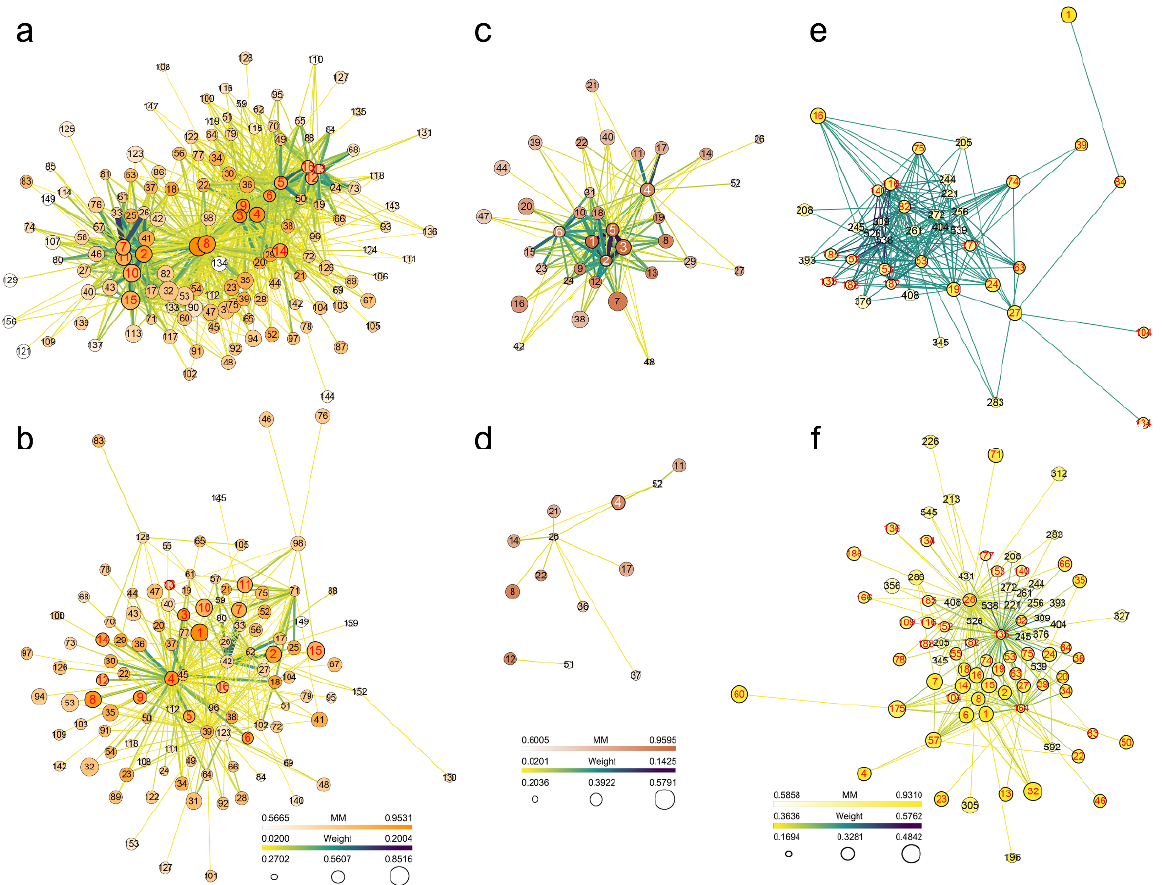
Figure 5. WGCNA revealed gene networks in the JA- and SA-related modules. ( a ) Gene network for hub genes in the JA-related module. ( b ) Gene network for plant–pathogen interaction-related and signalling-related genes in the JA-related module. ( c ) Gene network for hub genes in the bound SA-related module. ( d ) Gene network for plant–pathogen interaction-related and signalling-related genes in the bound SA-related module. ( e ) Gene network for hub genes in the free SA-related module (only genes with the top 200 highest weight values are shown). ( f ) Gene network for plant–pathogen interaction-related and signalling-related genes in the free SA-related module (only genes with the top 200 highest weight values are shown). The size of the dots represents GS. The colour of the dots represents MM. The colours and thicknesses of the lines represent the weight value between two genes. The labels of dots are listed based on IC, and the hub genes are highlighted with red or white colour labels. GS, gene significance; MM, module membership; IC, intramodular connectivity.